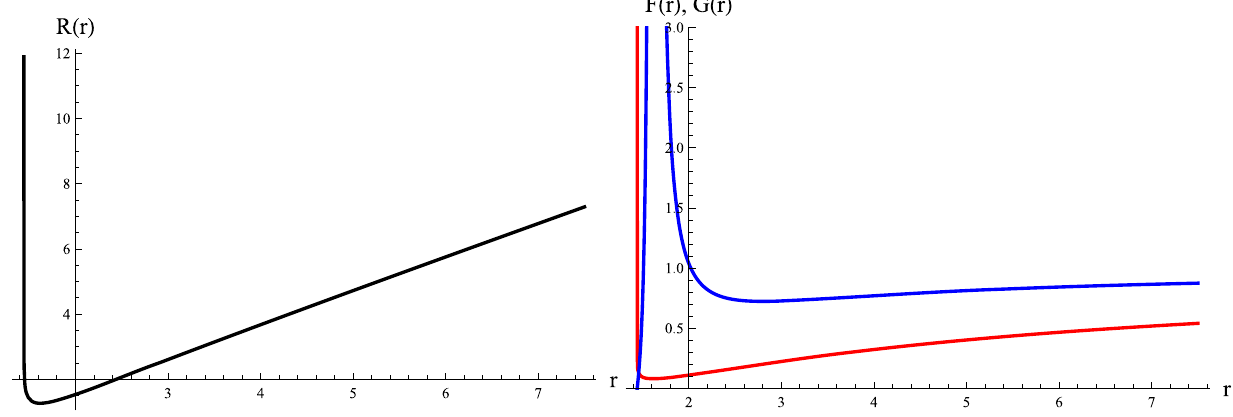
Fig. 2 Typical behaviors of R (left), F (right, red), and G (right, blue), where we have chosen a = 2, b = 3, and h = 1. For b ≥ a , the center is timelike since F is positive